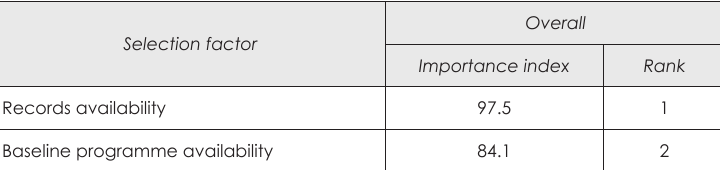
Table 4: Relevant importance of DAM selection